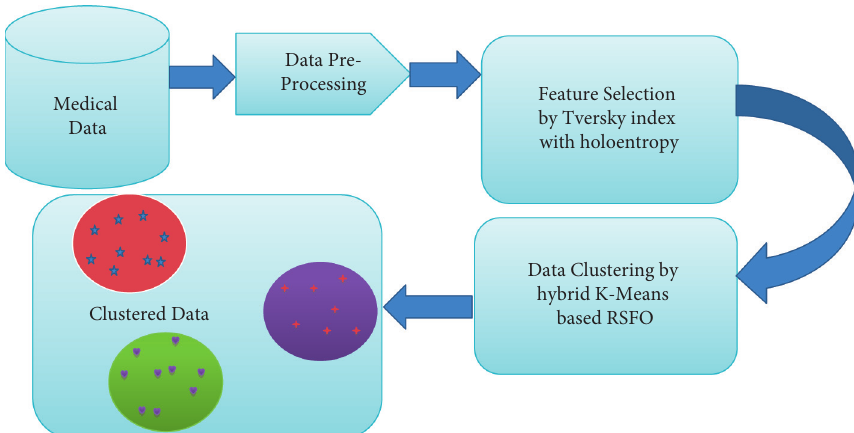
Figure 1: Pictorial representation of the proposed hybrid optimization-based